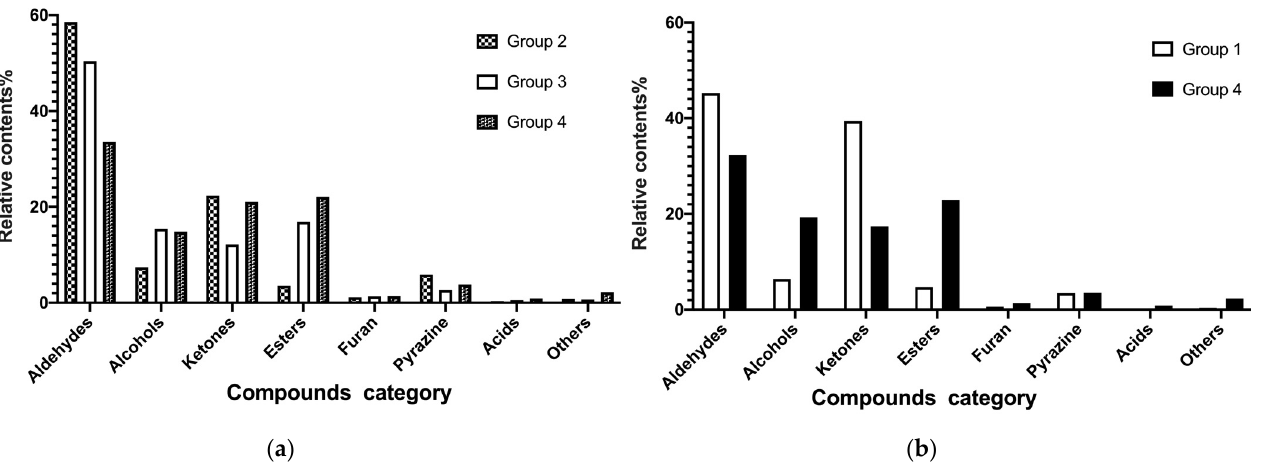
Figure 3. Comparative analysis of the relative contents (%) of volatile compounds in herbal broth subjected to enzymatic hydrolysis and fermentation. ( a ) Effect of enzymatic hydrolysis and fermentation; ( b ) Comparison of direct plant extraction and probiotic fermentation.